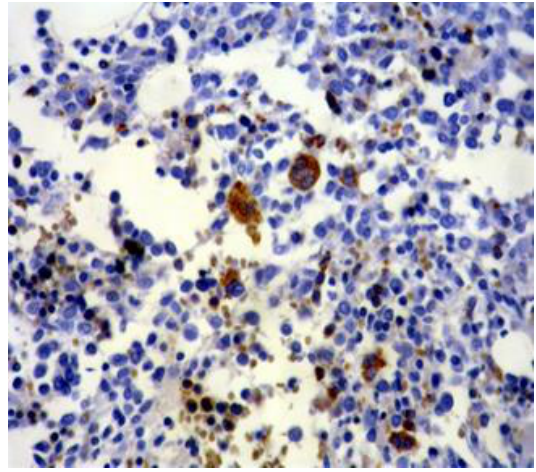
Fig 1. Normal bone marrow stained by α- synuclein. Erythroid precursors, RBCs, and megakaryocytes show strong staining, while the other cells are negative (x200).